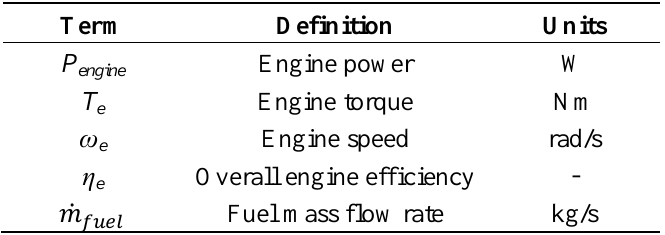
Table 1. Terms used for engine calculations.